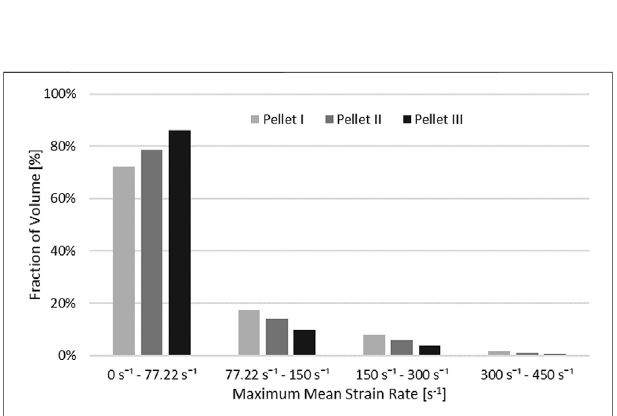
FIGURE 12 | Volume fraction of the spinal cord that was subjected to maximum mean strain rate.